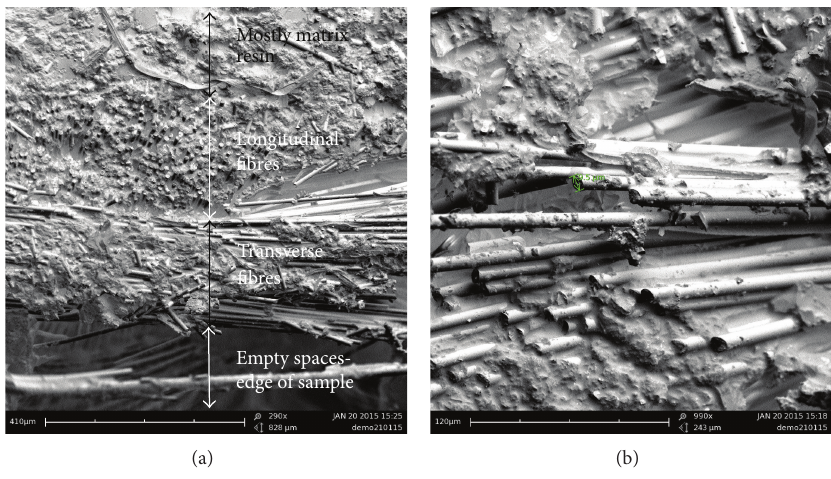
Figure 11: SEM micrograph of hybrid GFRP at (a) 290x (b)